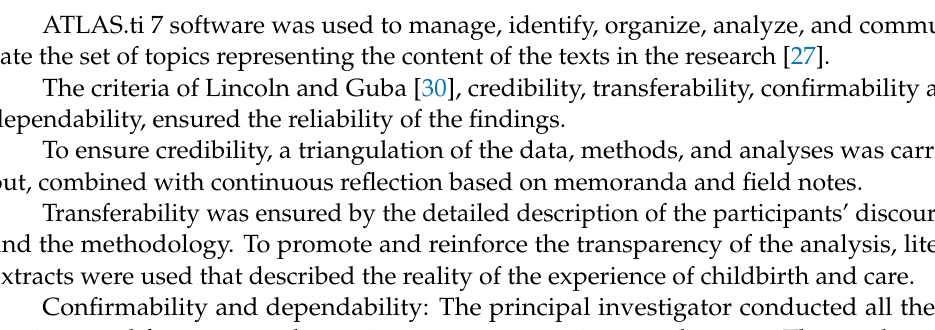
Figure 1. Creation of the semantic network in the analysis process.